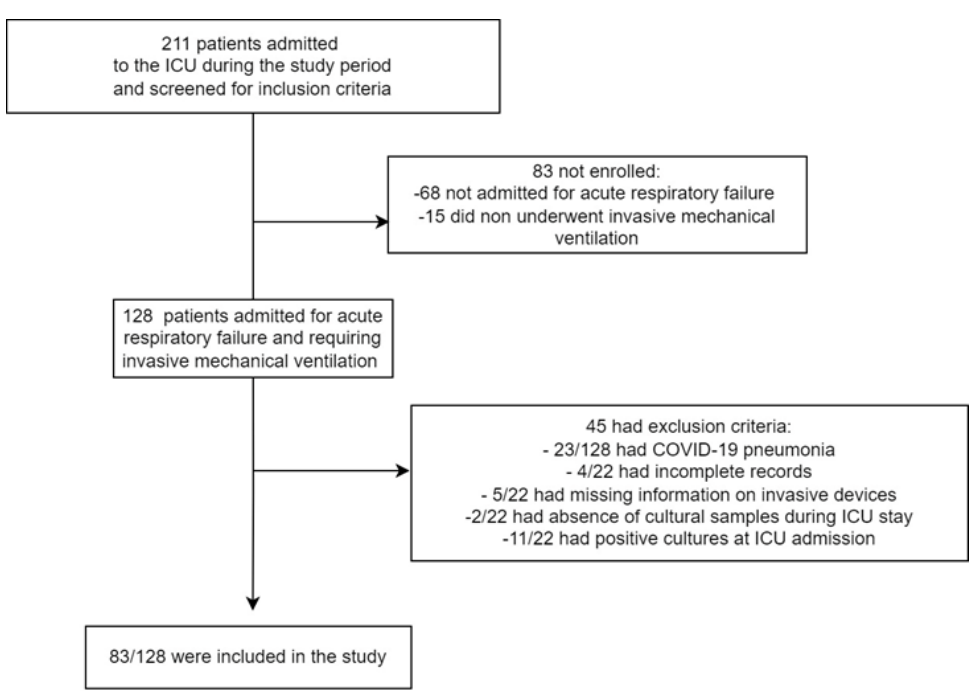
Figure 1. Flow diagram of patient selection process. Table 2. Clinical features (outcomes, therapies, ventilatory, catheter and others) during ICU